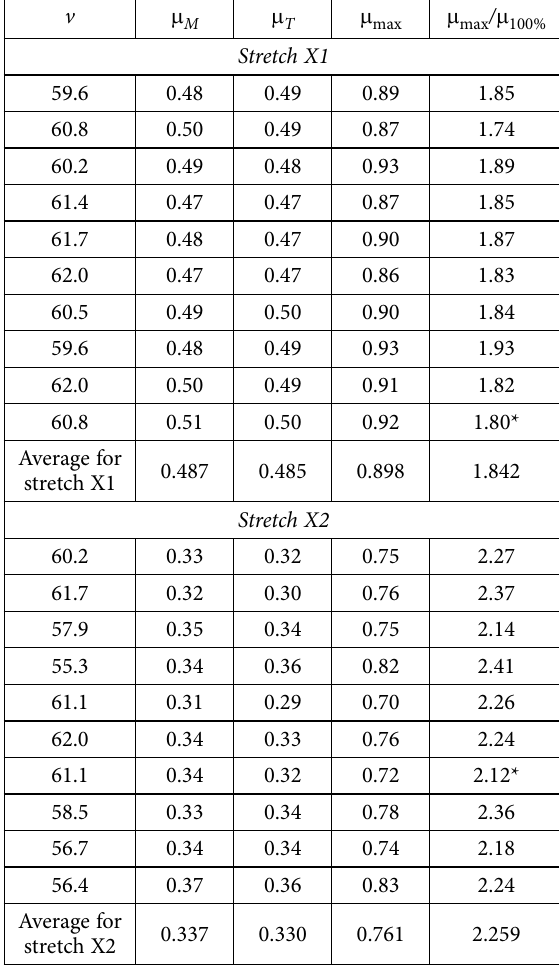
Table 3. Measurement results for road stretches X1 and X2